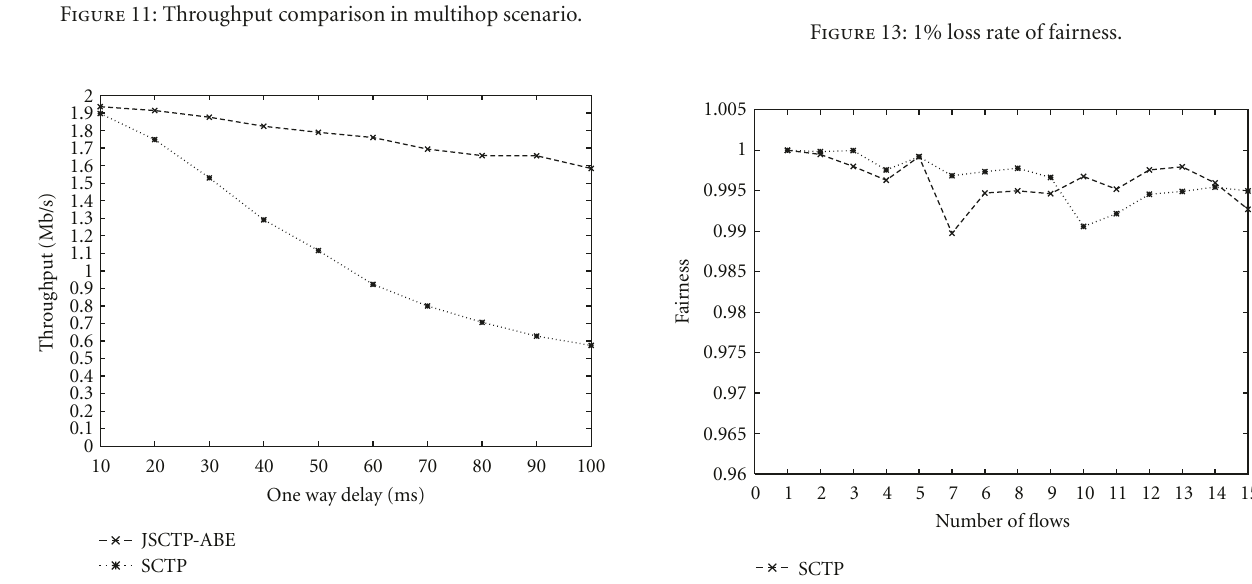
Figure 11: Throughput comparison in multihop scenario.